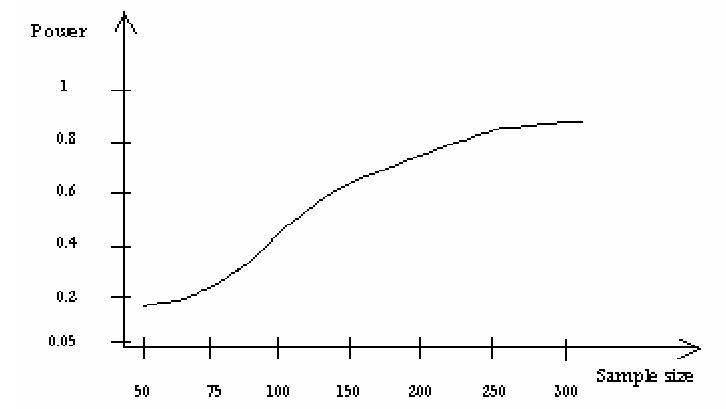
Figure 13 – Dominant model with odds ratios = 2, f = 0.10, (cid:118) =